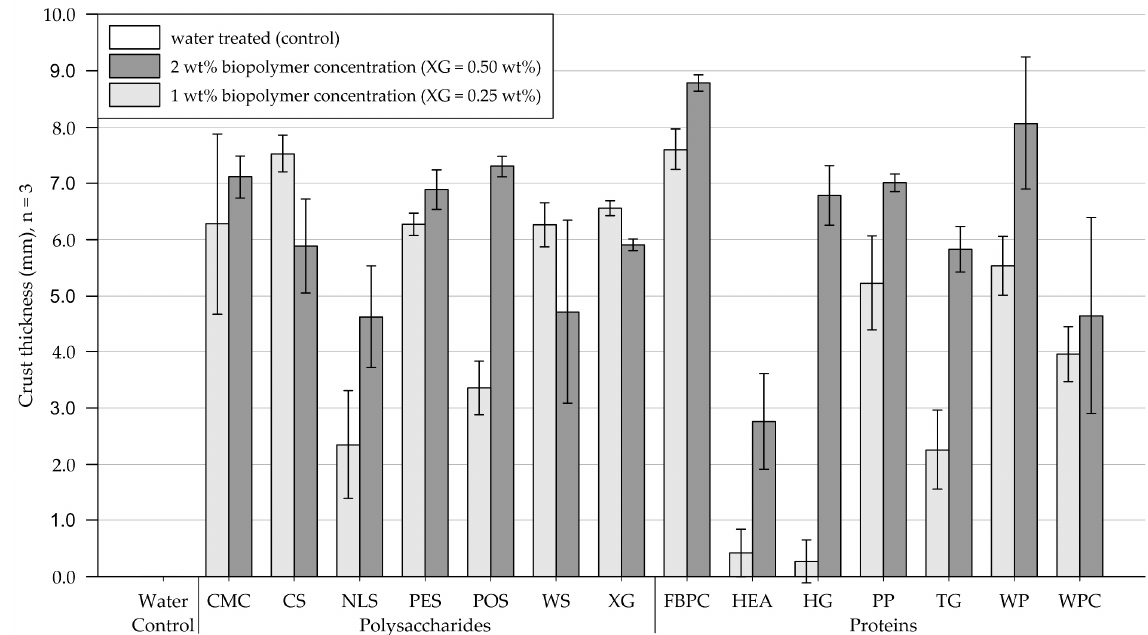
Figure 9. Mean thickness of crust formed on medium-grained sand samples. Biopolymers are grouped into polysaccharides and proteins with water as control. Tests were performed with six replicas ( n = 3), with error bars indicating the standard deviation (SD). Note. The exact values of experimental results are appended in Table A5.